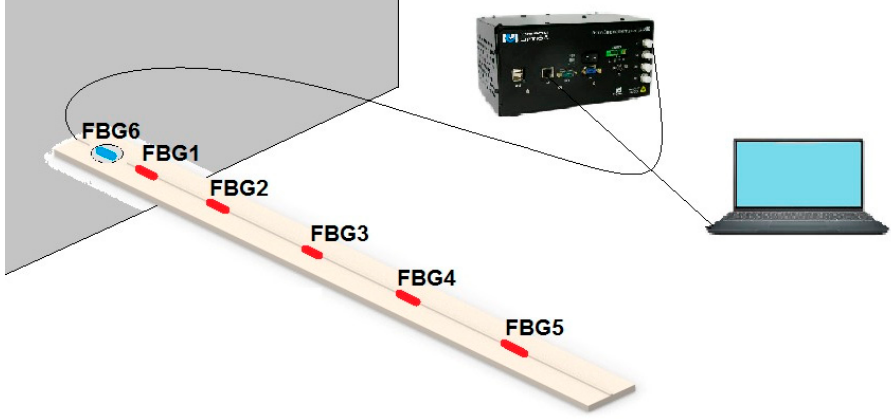
Figure 1. Experimental setup of the beam characterization method.